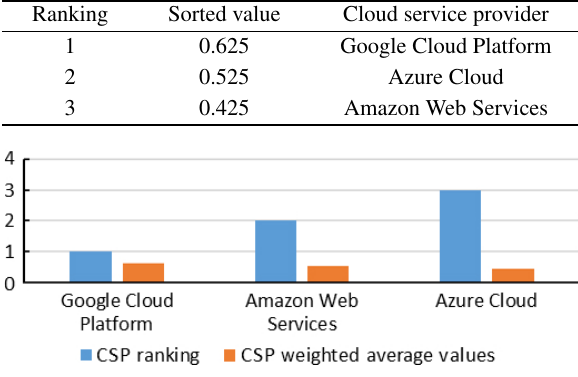
Table 13 Weighted average values and ranking in Experiment 1.